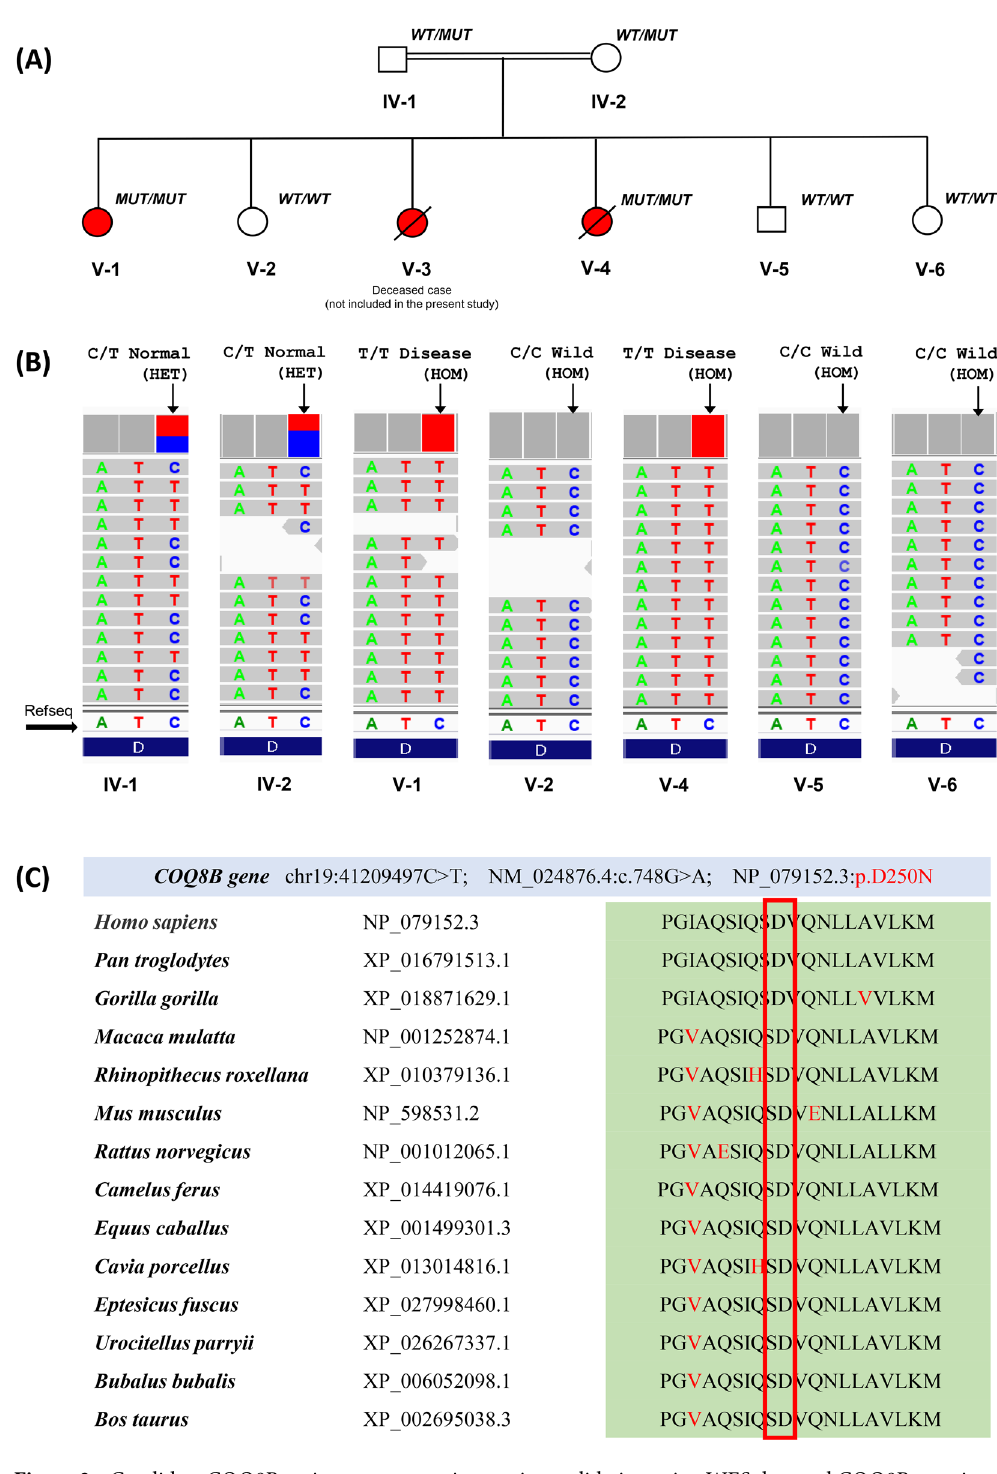
Figure 3. Candidate COQ8B variant co-segregation, variant validation using WES data and COQ8B protein conservation. ( A ) Pedigree showing the co-segregation of COQ8B variant (NM_024876.4:c.748G > A; NP_079152.3:p.D250N) in the family. Cases are presented in red color. ( B ) Whole-exome sequencing data (using IGV 2.5.3 software) reflects exactly the phenotypic data with homozygous cases (V-1 and V-4), heterozygous normal parents (IV-1 and IV-2) and three normal with homozygous reference allele (V-2, V-5 and V-6). ( C ) Comparing COQ8B protein for 14 vertebrates showed a highly conserved region at the mutation site